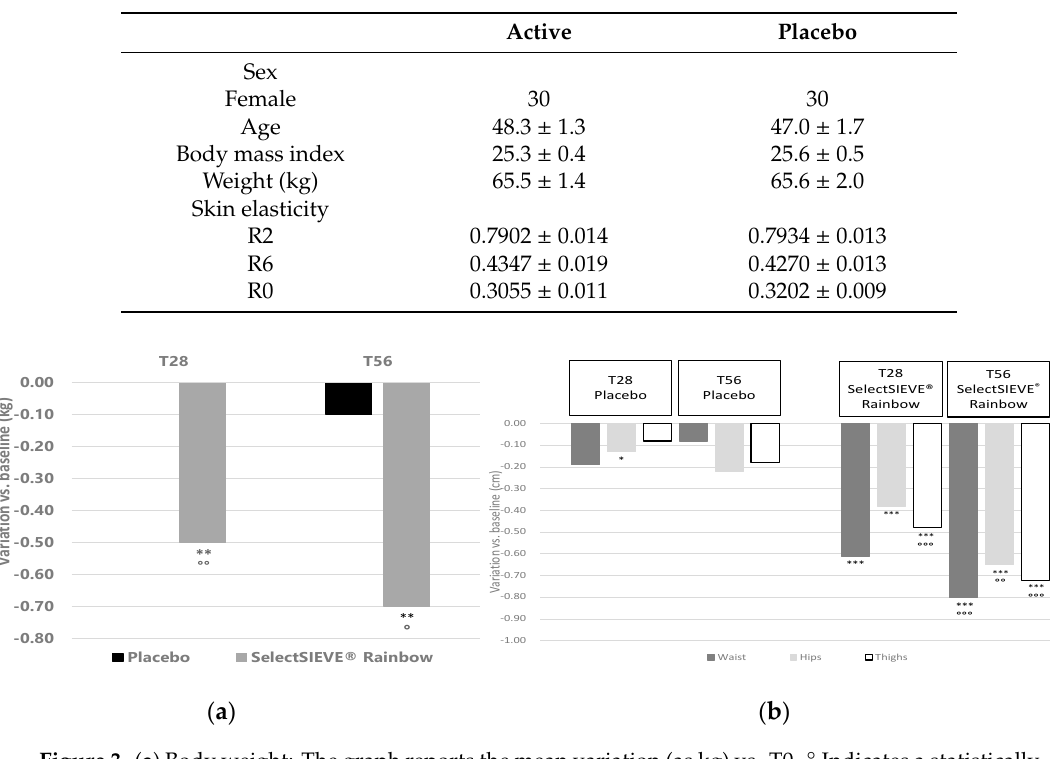
Figure 3. ( a ) Body weight: The graph reports the mean variation (as kg) vs. T0. ◦ Indicates a statistically significant change compared to T0, p < 0.005; ◦◦ Indicates a statistically significant change compared to T0, p < 0.001. * Indicates a statistically significant change compared to placebo, p < 0.05; ** Indicates a statistically significant change compared to placebo, p < 0.01. ( b ) Body circumference: The graph reports the mean variation (as cm) vs. T0. ◦ Indicates a statistically significant change compared to placebo, p < 0.05; ◦◦ Indicates a statistically significant change compared to placebo, p < 0.01. ◦◦◦ Indicates a statistically significant change compared to placebo, p < 0.001. * Indicates a statistically significant change compared to T0, p < 0.05; ** Indicates a statistically significant change compared to T0, p < 0.01. *** Indicates a statistically significant change compared to T0, p < 0.001. Data are expressed as means ± SEM.